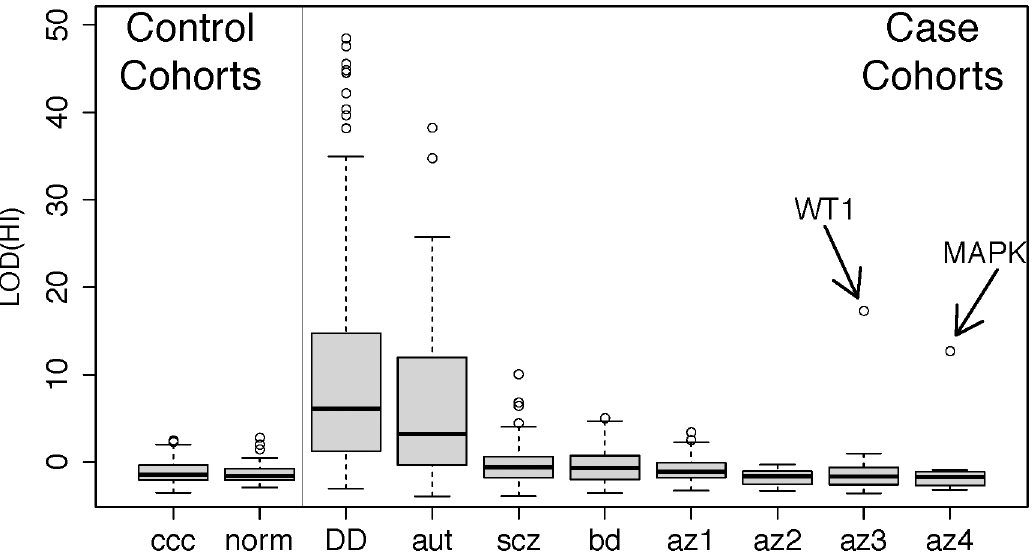
Figure 3. Disruption of predicted haploinsufficient genes is infrequent in spermatogenic failure. We obtained lists of rare deletions, left panel, from the Utah and WTCCC control cohorts and, right panel, from cohorts of developmental delay (DECIPHER) [66], autism [67], schizophrenia [68], bipolar disorder [66,68], and spermatogenic impairment (this study). We used a published method for assessing the likelihood that each deletion disrupts a haploinsufficient gene [47], summarized as a LOD score, and ordered each cohort by the median LOD(HI) within cases and controls separately. While the CNVS from DECIPHER (p , 1 6 10 2 15 ), autism (p , 1 6 10 2 15 ), schizophrenia (p , 1 6 10 2 4 ) and bipolar disorder (p , 0.002) show significant enrichment of high LOD (HI) scores compared to controls, the infertility cohorts have score distributions indistinguishable from controls. Two outlier deletions from the infertility cohort are annotated; one is a deletion of WT1 , a key gene in gonadal differentiation, and the other is a 1 Mb deletion involving several genes including MAPK1 and the cancer-testis antigen PRAME . Further review of clinical data from the WT1 carrier showed signs of cryptorchidism. Abbreviation of azoospermia cohorts: az1, Utah cohort, az2, WUSTL, az3 Porto, az4, Weill-Cornell. Note that for additional detail we have split the cohort referred to as ‘‘Porto’’ in the main text into two subgroups, az3 and az4, defined by the clinical group that ascertained the cases.